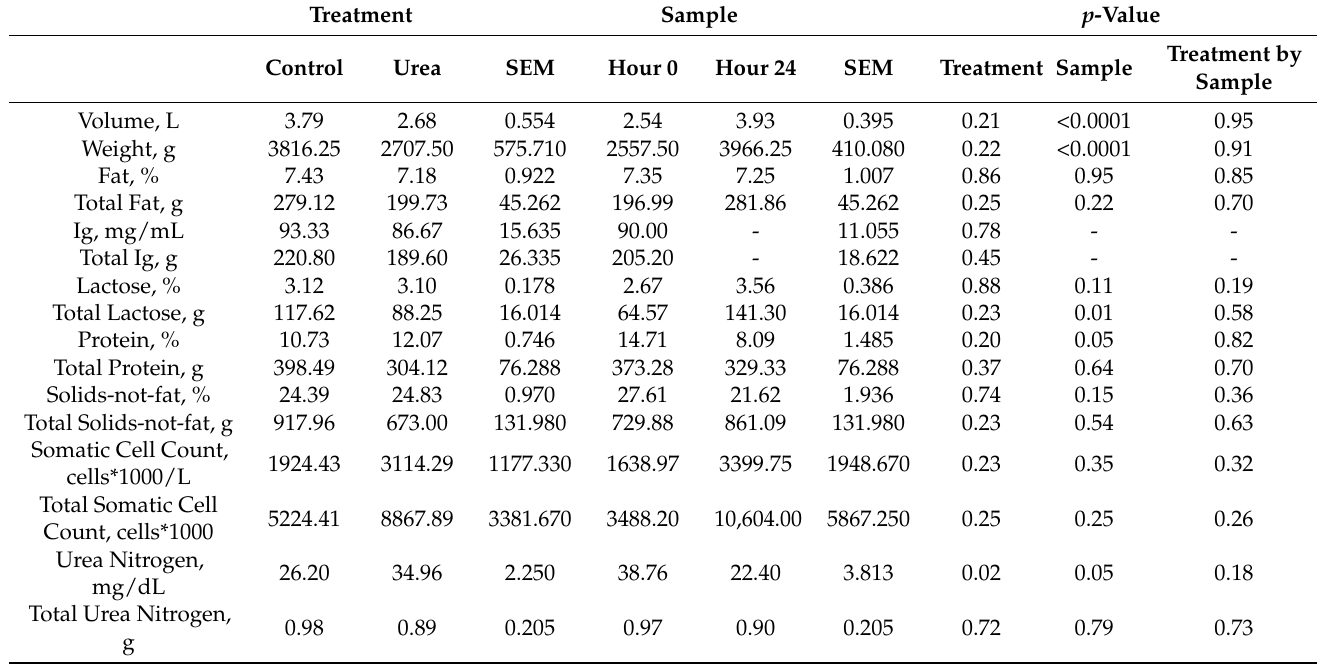
Table 3. The effects of dietary urea during gestation on mammary secretion volume, weight, and composition in samples collected at 0 and 24 h after parturition. Dietary treatments were: Control (0 g urea/animal/day) or Urea (80 g urea/animal/day). Treatments were offered from day 28 of gestation to parturition. Total mammary secretion composition was calculated as parameter multiplied by mammary secretion weight (fat, lactose, protein, and solids-not-fat) or volume (Ig, somatic cell